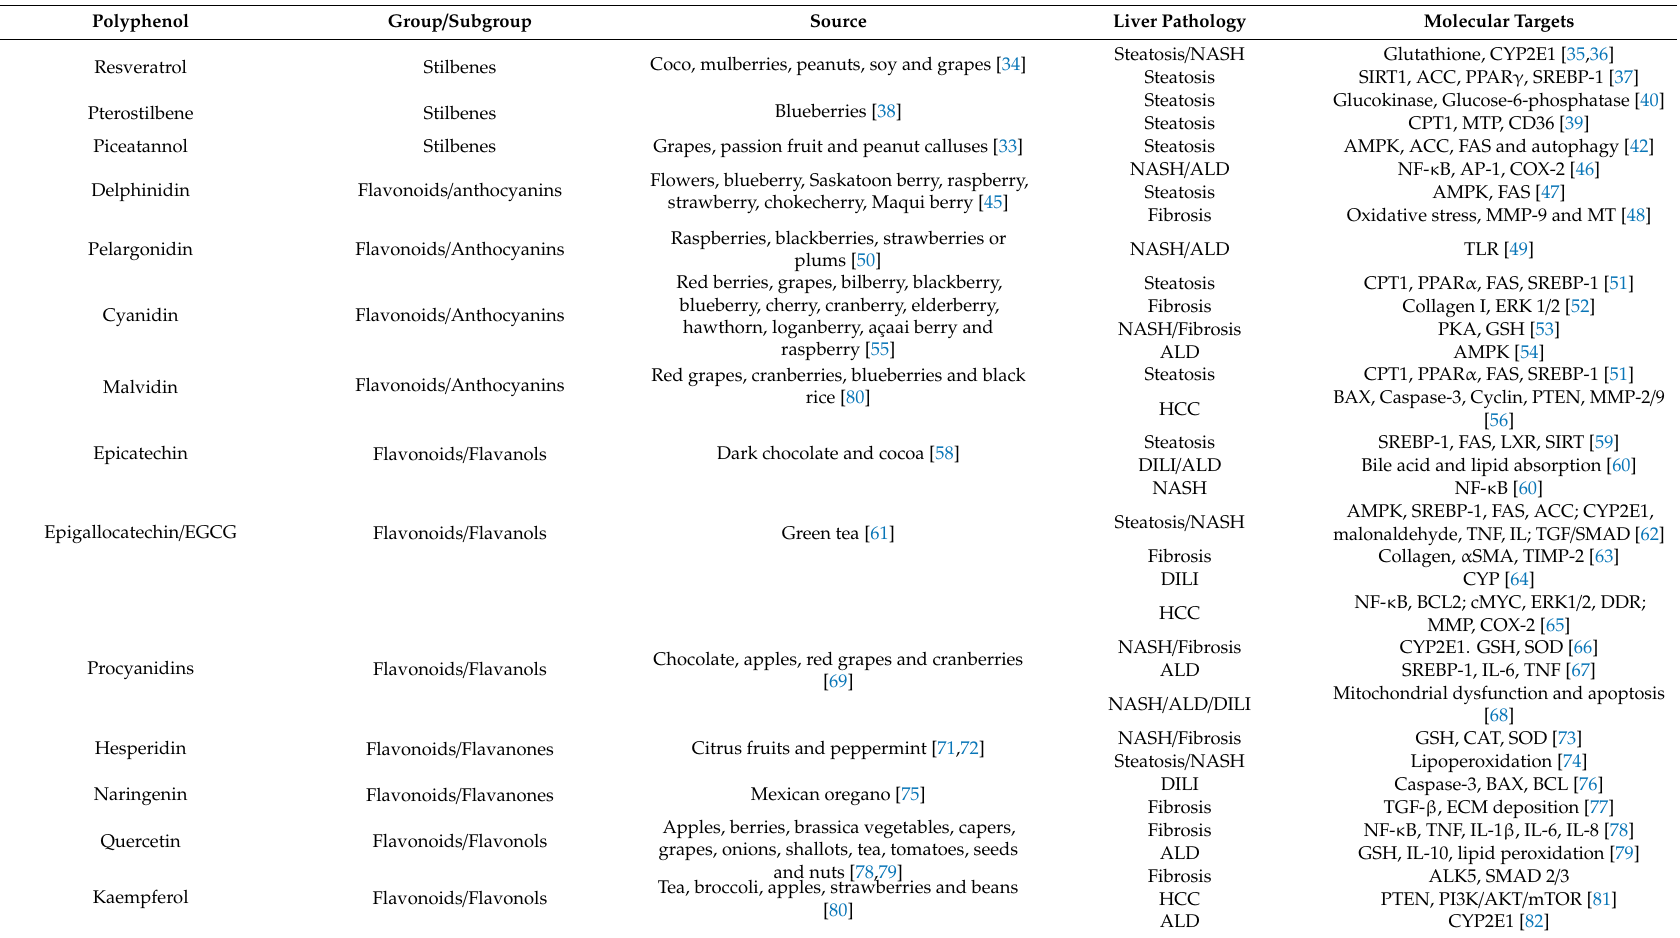
Table 2. List of most relevant polyphenols, their richest sources and pathologies with potential beneficial properties with each respective molecular